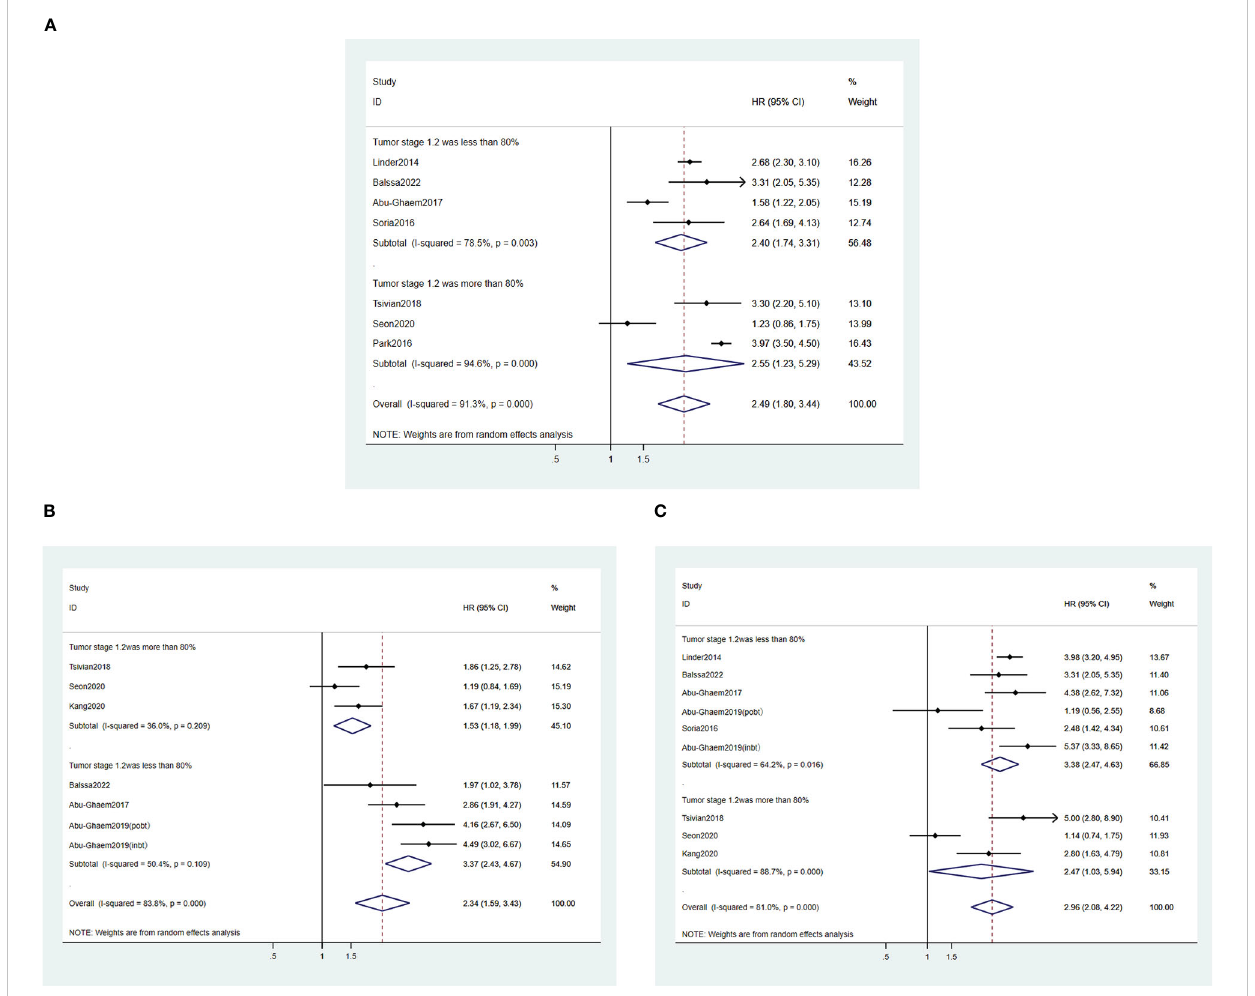
FIGURE 5 Forest plot depicting the association between (A) tumor staging and OS; (B) tumor staging and RFS; (C) tumor staging and CSS. An HR value greater than 1 is detrimental to survival, implying that tumor staging did not affect PBT and poorer postoperative